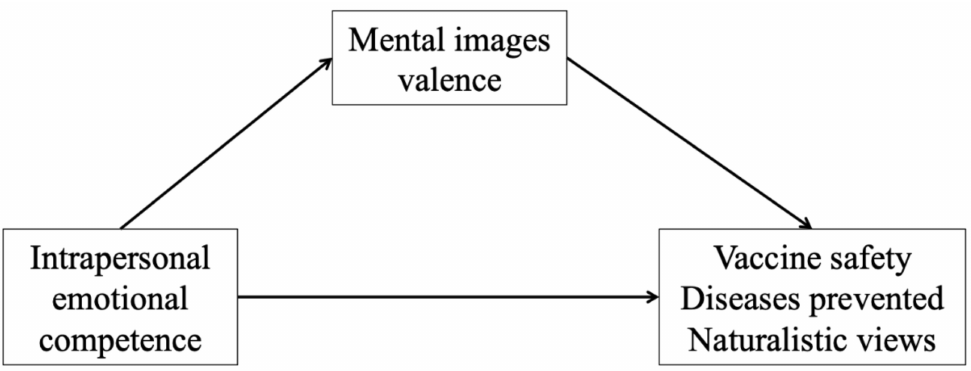
Figure 1. Path of the mediation analyses (Study